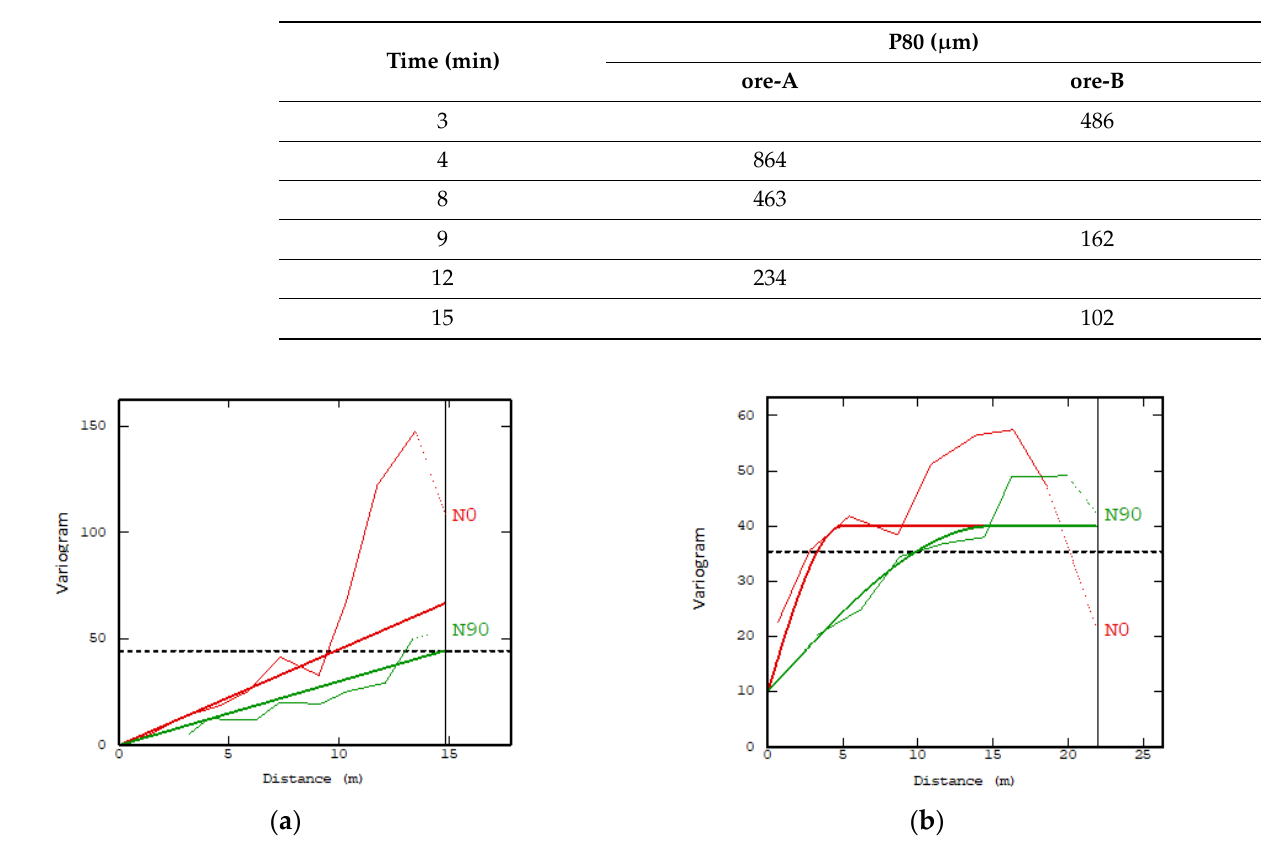
Figure A3. Experimental (thin line) and modeled (thick line) data with anisotropic variograms: ( a ) LGP-2 for ore-A with directions: north: 0° (red) and directions: north: 90° (green); ( b ) LGP-2 for ore-B with directions: north: 0° (red) and directions: north: 90° (green).